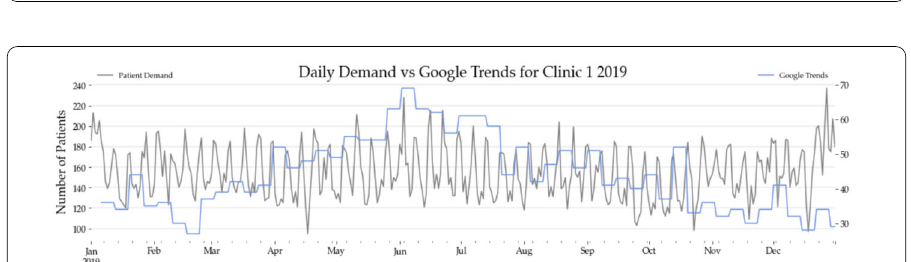
Figure 13 Flu Tracker Proxy Feature for 2019 and 2020